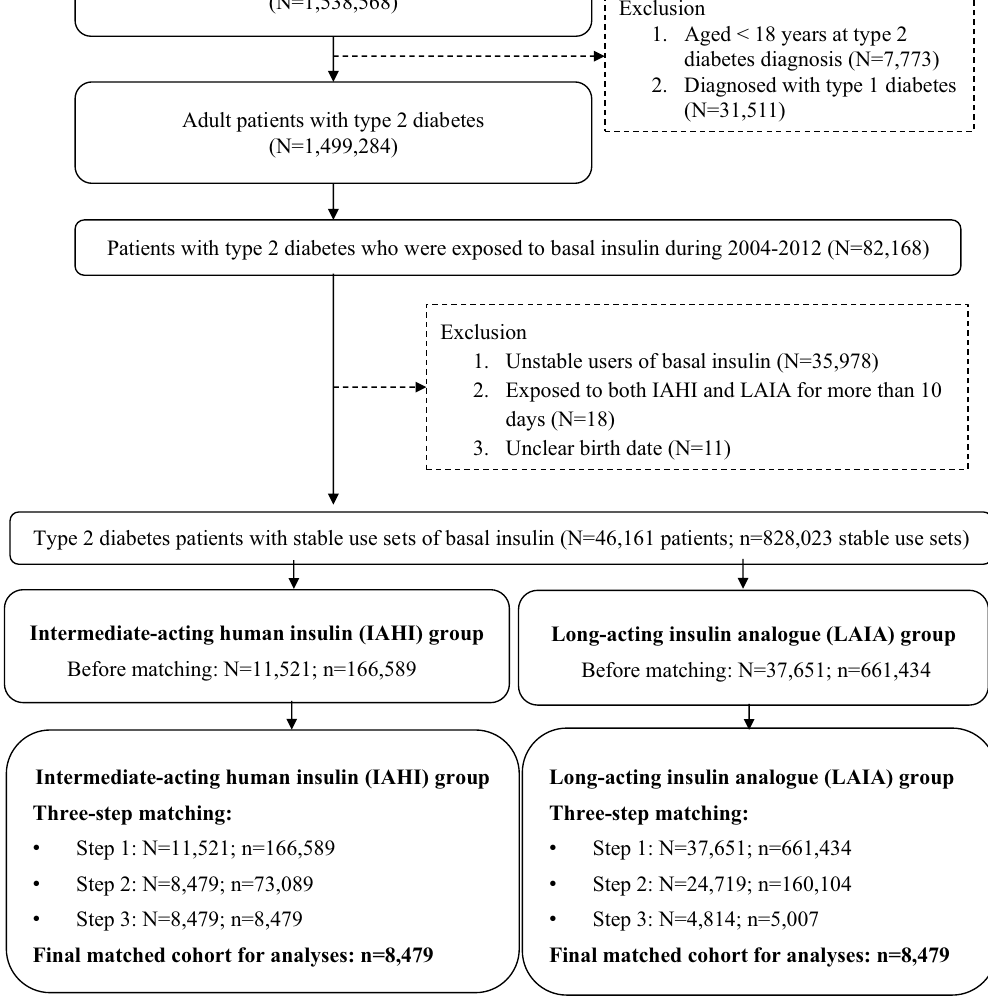
Figure 1. Flowchart of the study population selection and identification. (1) “N” represents the number of patients, and “n” represents the number of stable use sets. (2) Matching steps: (1) Step 1: matched by the cohort entry time (i.e., matching of the index date between the two study drug groups; the index date refers to the first date of IAHI or LAIA use). (2) Step 2: matched by the utilization pattern of glucose-lowering agents within 1 year prior to the index date. (3) Step 3: matched by the propensity score estimated based on patient characteristics measured within 1 year prior to the index